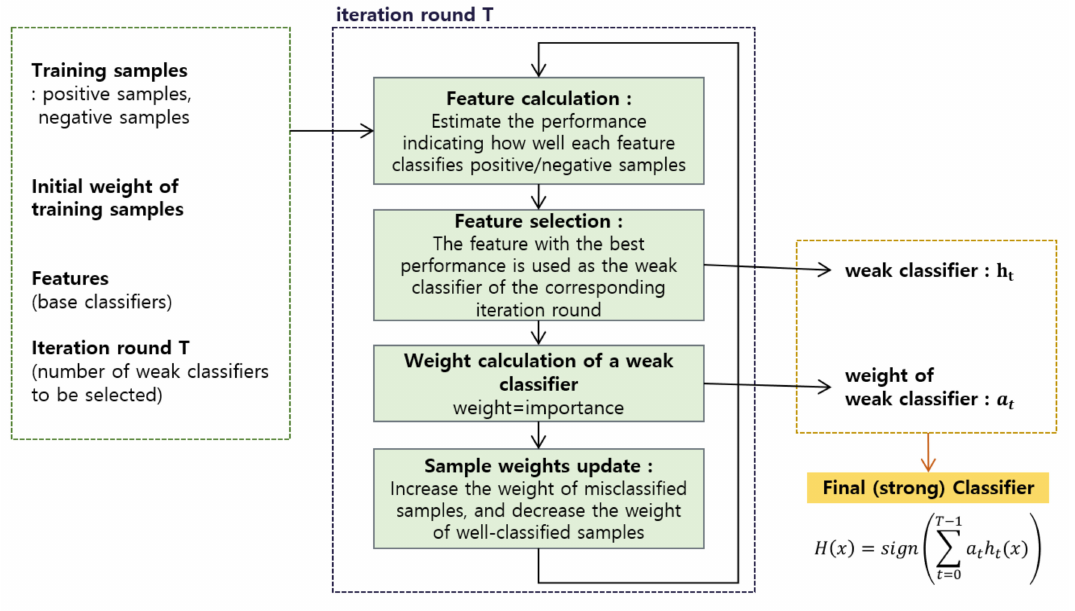
Figure 1. The process of